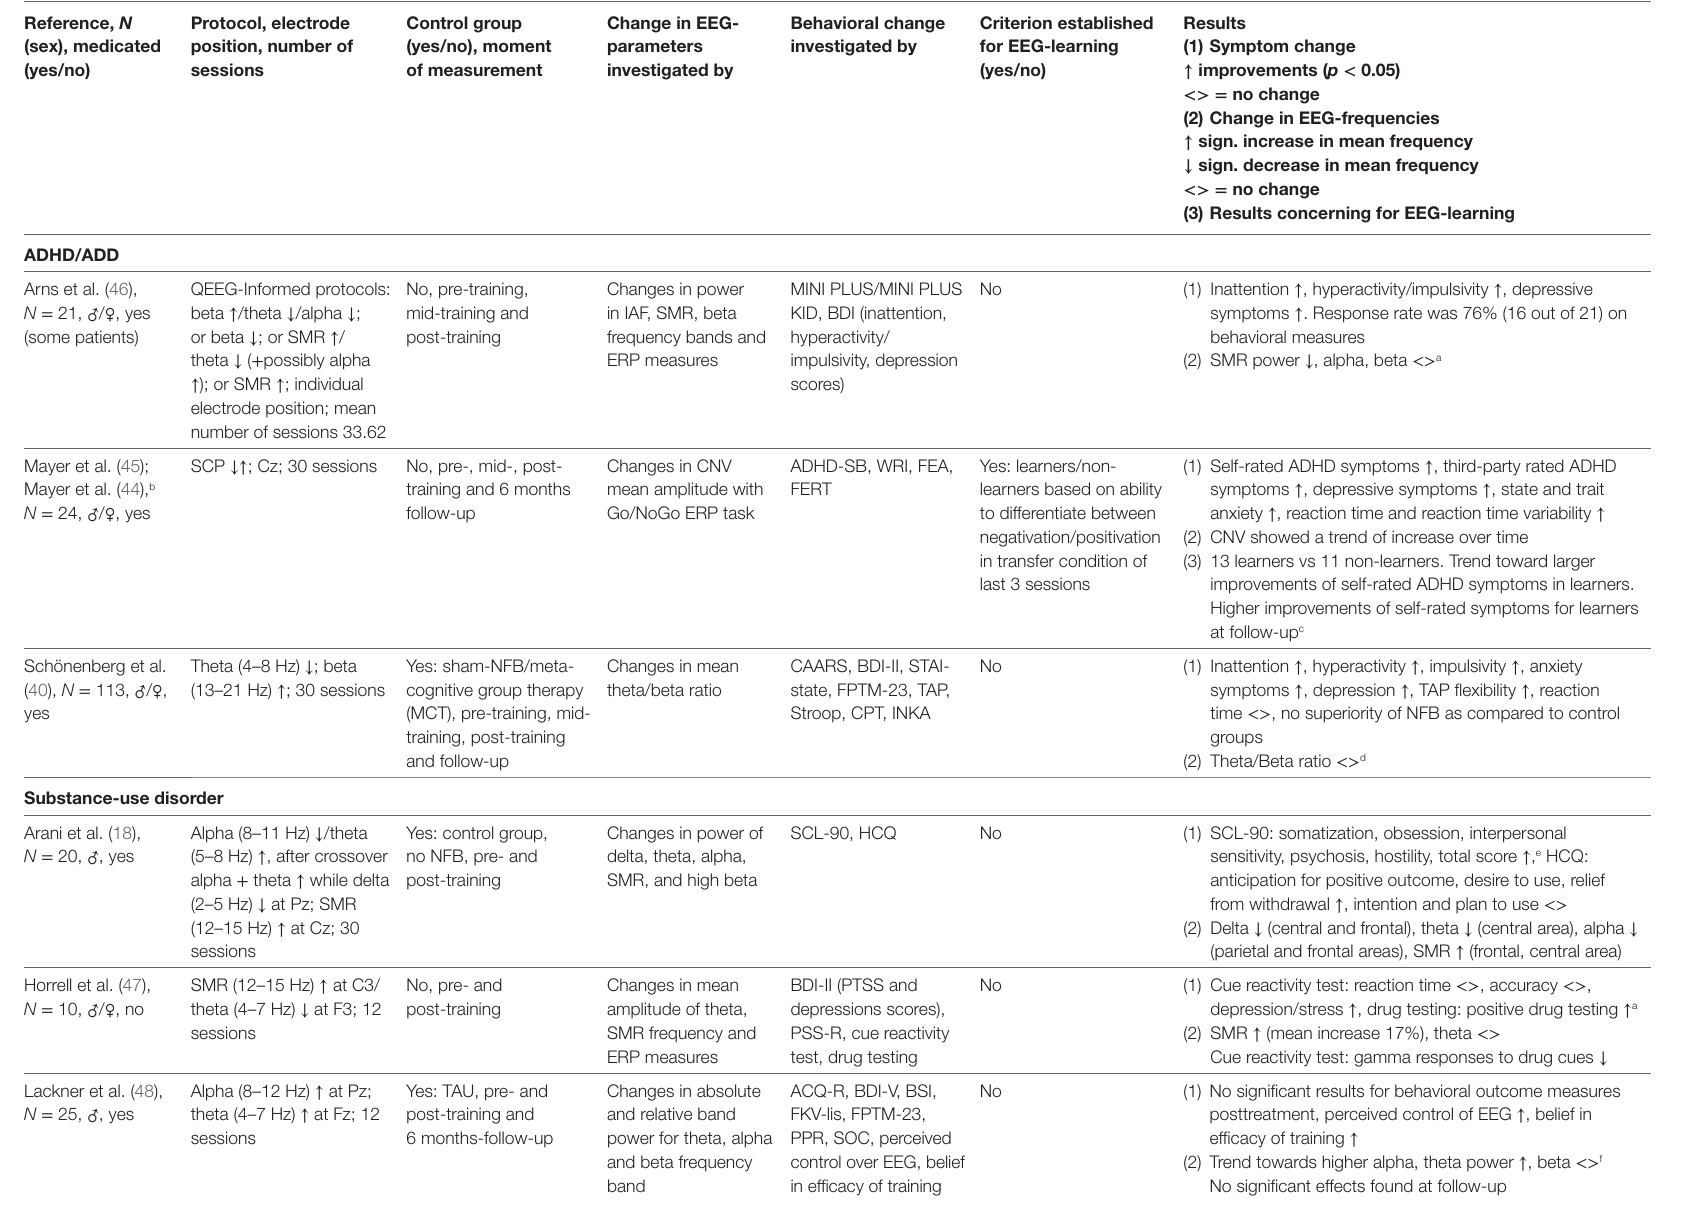
TABLe 1 | Characteristics of the included studies ( N =